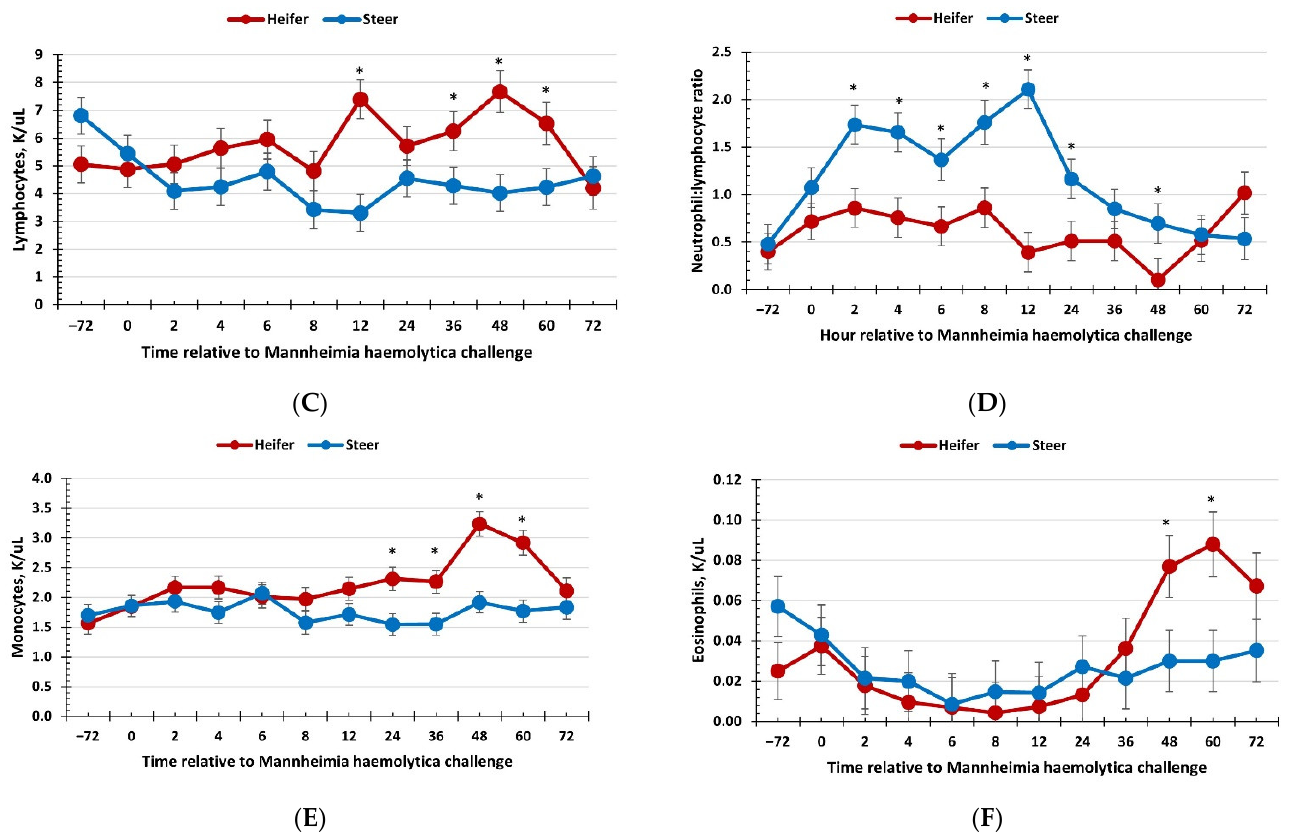
Figure 2. Influence of calf sex on the hematology response to a dual viral–(bovine herpesvirus-1; 1 × 10 8 pfu/nostril) bacterial ( Mannheimia haemolytica ; 1.3 × 10 7 cfu) respiratory disease challenge. ( A ) White blood cells: there was a sex × time interaction ( p = 0.05) where heifers had less white blood cells at −72 and 0 h but had greater concentrations at 36, 48, and 60 h compared to steers. ( B ) Neutrophils were reduced in heifers at 0, 2, 4, 8, and 12 h compared to steers (sex × time: p = 0.03). ( C ) Lymphocytes were greater in heifers compared to steers at 12, 36, 48, and 60 h post-challenge (sex × time: p < 0.01). ( D ) The neutrophil:lymphocyte ratio was reduced in heifers from 2 to 24 h and at 48 h post-challenge (sex × time: p < 0.01). ( E ) Monocytes were greater in heifers from 24 to 60 h post-MH challenge (sex × time: p < 0.01) and ( F ) eosinophils were greater in heifers than steers at 48 and 60 h post-challenge (sex × time: p < 0.01). * Sexes differ p ≤ 0.05.